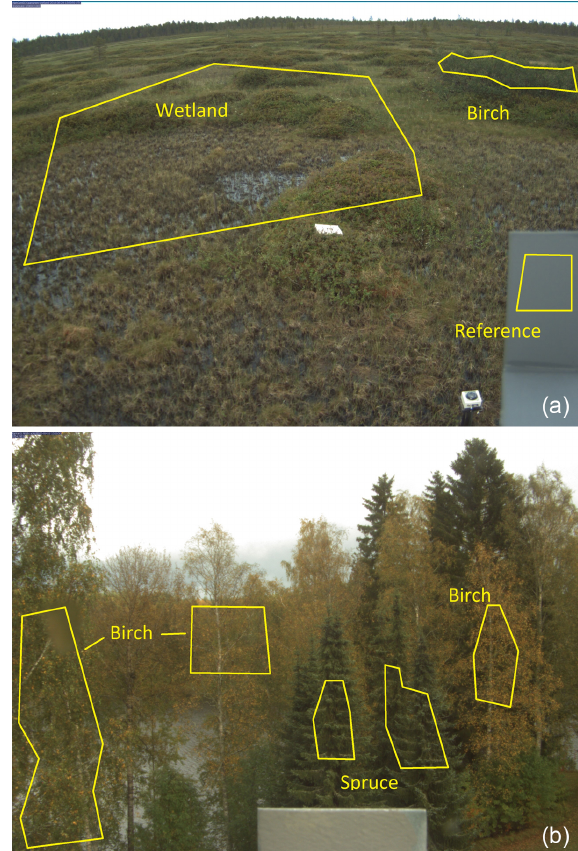
Figure 3. Regions of interest used in GCC time series construc- tion. (a) Kaamanen wetland site (camera MC128), with Sphagnum spp and grasses (Wetland ROI), shrubs like pubescent birch ( Betula pubescens subsp. Czerepanovii) (birch), and reference grey plate. (b) Parkano site (camera MC112), with silver birches ( Betula pen- dula ) ROI distributed in three separated polygons (birch), and Nor- way spruce ( Picea abies L. Karst)